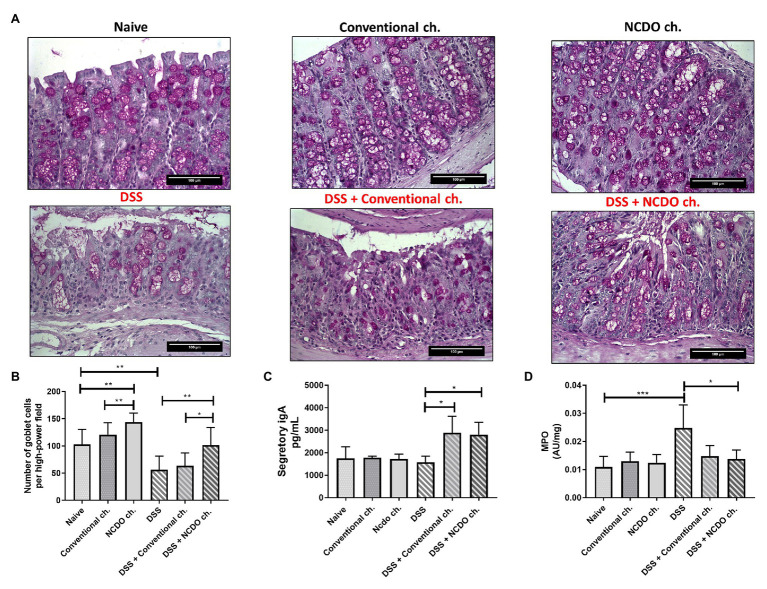
Effect of probiotic cheese administration on goblet cells, secretory immunoglobulin A (sIgA) levels, and the enzyme activity of myeloperoxidase (MPO). (A) Representative Periodic acid-Schiff (PAS) staining of colon mucosa sections. (B) Number of goblet cells, given by counting intact cells in 10 random field images on mouse colon. (C) Quantification of sIgA in the small intestine. (D) Levels of MPO activity that indirectly determines the neutrophil concentration in 10 mg of colon tissue. Values indicate the mean ± standard deviation (n = 6). Image acquisition was done with a 20× magnification objective. Scale bar = 100 μm (n = 6). Asterisks represent statistically significant differences: *p < 0.05, **p < 0.01, ***p < 0.001.